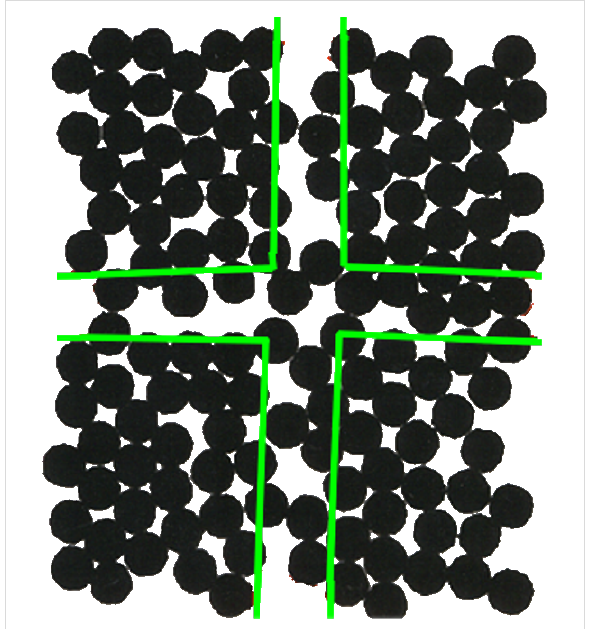
Figure 1: Schematic representation of the interface in a nano-glass